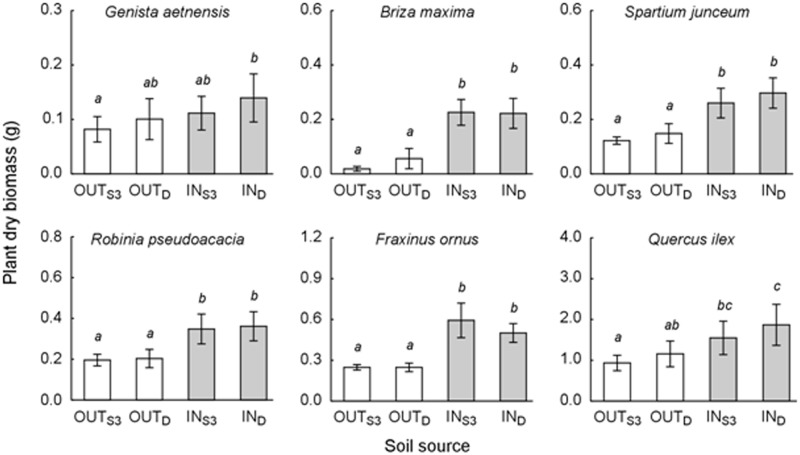
Plant growth in the greenhouse bioassay.Plant dry biomass of six target species pot-grown on soil collected at the Vesuvius Grand Cone, outside and under the canopy of either living (OUTS3 and INS3, respectively) or dead (OUTD and IND, respectively) Genista aetnensis adult individuals. For each species and within each treatment, data refer to mean and 95% confidence interval of single plant dry mass (g) from 15 replicated pots. Different small letters indicate statistically significant difference among soil types (Post-hoc Duncan test at p<0.05, from two-way ANOVA in S7 Table).